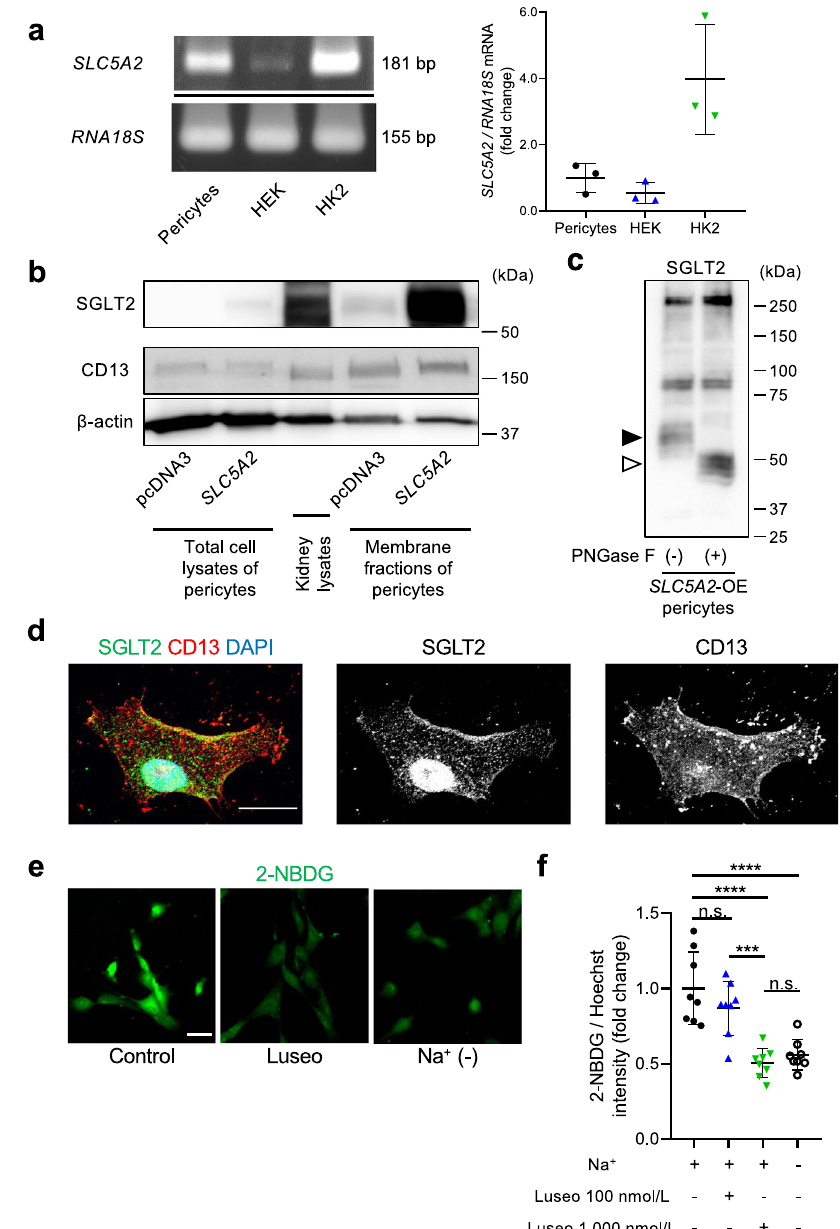
Fig. 3 Glucose uptake in brain pericytes via SGLT2. a Representative example of the expression of SLC5A2 (SGLT2) in cultured human brain microvascular pericytes, HEK-293T, and HK2 cells assessed using RT-PCR and quanti fi cation using qPCR ( n = 3). The mRNA expression was normalized to that of RNA18S . b Representative immunoblottings for SGLT2, CD13, and β -actin in cultured pericytes of total lysates or membrane fractions obtained by ultracentrifugation, which were transfected with pcDNA3 or pcDNA3- SLC5A2 . Human kidney lysates were used as a positive control for SGLT2 expression. c A representative immunoblotting for SGLT2 in cultured brain pericytes after SLC5A2 overexpression with or without PNGase F treatment. The black arrowhead indicates glycosylated SGLT2 and the white arrowhead indicates unglycosylated SGLT2. d Representative images of immuno fl uorescence for SGLT2 (green), CD13 (red), and DAPI in a cultured brain pericyte (scale bar = 20 μ m). e , f ( e ) Brain pericytes were incubated in Na + -containing HEPES- buffered saline, Na + -free solution, or Na + -containing solution with 100 or 1,000 nmol/L luseogli fl ozin for 15 min, followed by incubation with additional 200 μ mol/L of 2-NBDG (scale bar = 20 μ m). f Fluorescence intensity of 2-NBDG was measured using a microplate reader and normalized to that of Hoechst 33342 ( n = 8). Data are presented as dot-plots of individual experiments and mean values ± SD. n.s. (not signi fi cant) P > 0.05, *** P < 0.001, **** P < 0.0001 by One-way ANOVA followed by Bonferroni ’ s post hoc test. SGLT2 sodium-glucose cotransporter 2, Luseo luseogli fl ozin, pMCAO permanent middle cerebral artery occlusion, 2-NBDG 2-deoxy-2-[(7-nitro-2,1,3-benzoxadiazol-4-yl) amino]- D